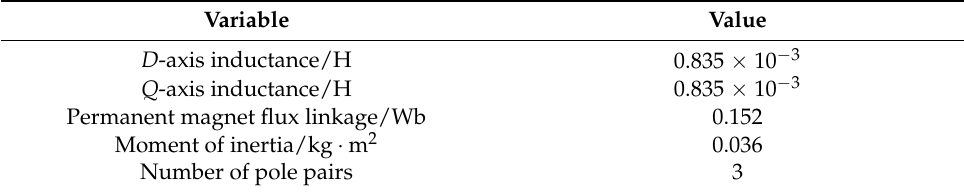
Table 3. Permanent magnet synchronous motor parameters.